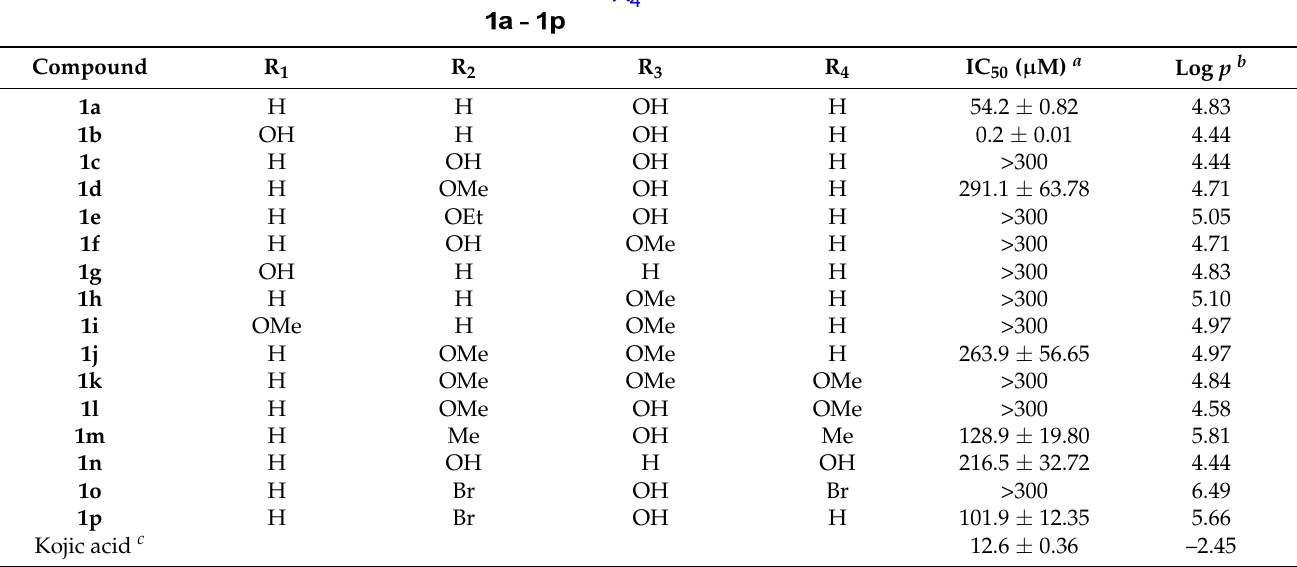
Table 2. The IC 50 values of 2-(substituted phenyl)-5-(trifluoromethyl)benzo[ d ]thiazole analogs 1a – 1p and their log P values.